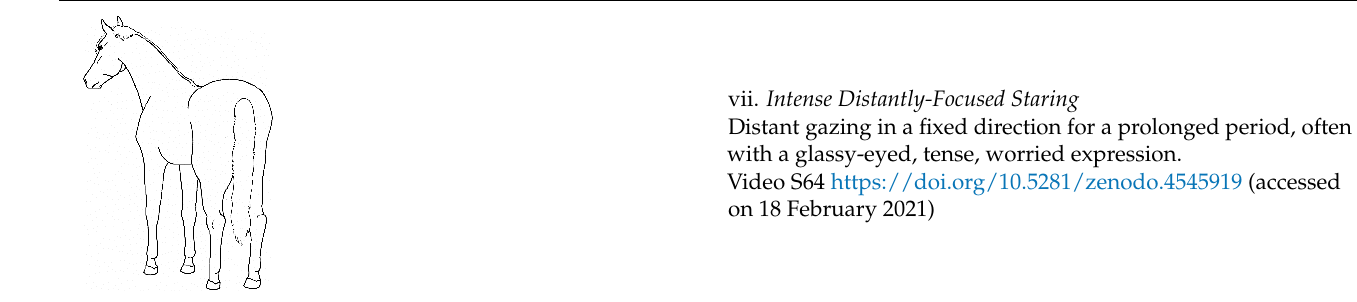
Table 7. Altered eating or drinking.